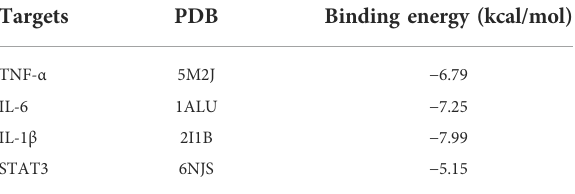
TABLE 1 Result of molecular